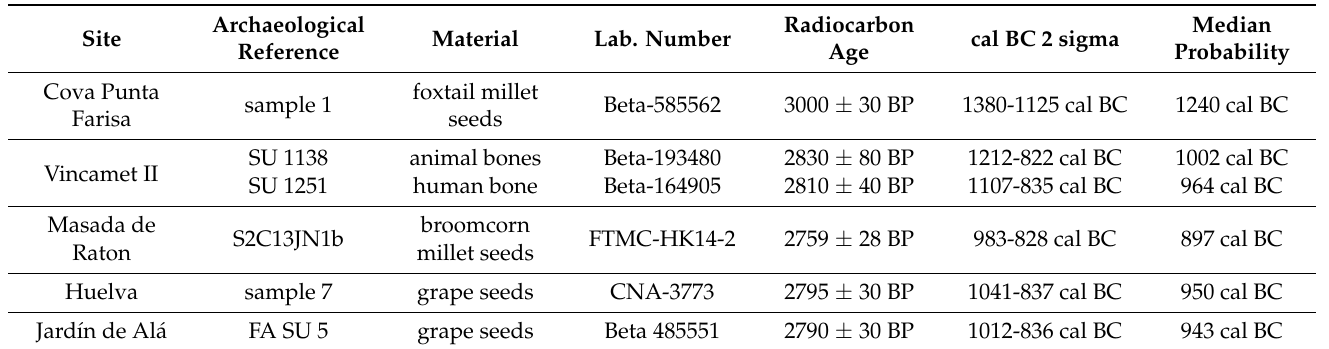
Table 2. Radiocarbon datings of millet seeds and other materials directly related to some of the earliest recorded remains. Calibrated with CALIB Rev